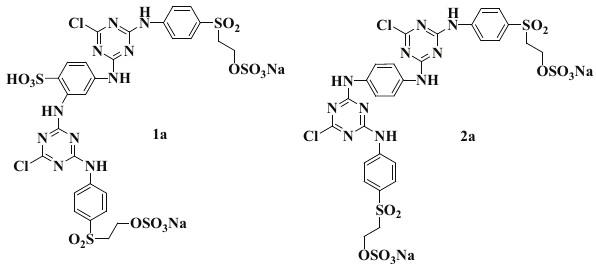
Figure 1: Structures of UV absorbers (1a-2a) selected for